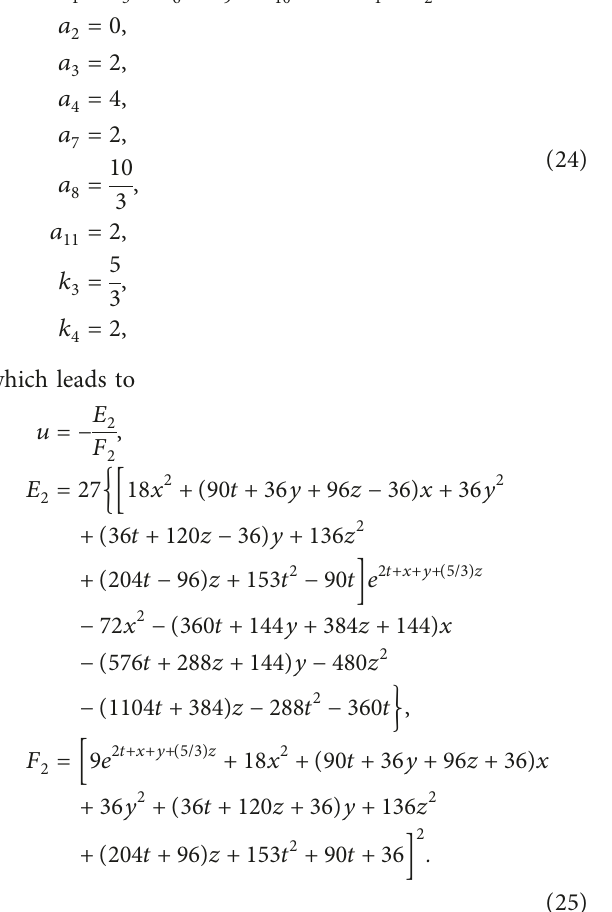
Figure 3 in three-dimensional and Figure 4 in